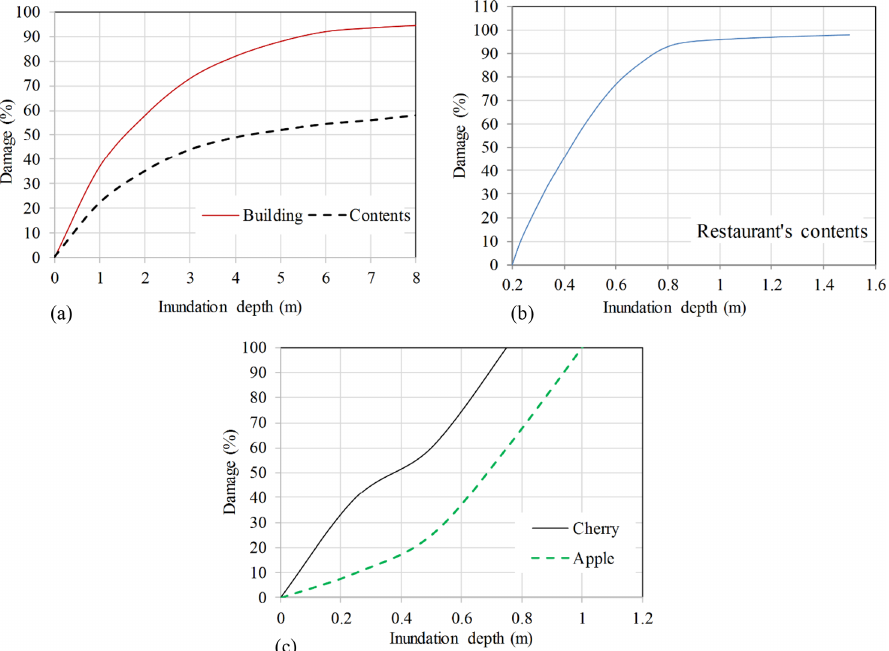
Figure 2. Damage–depth curves for different land uses of (a) a building and its contents, (b) a restaurant’s contents, and (c) agriculture in the Kan River basin.